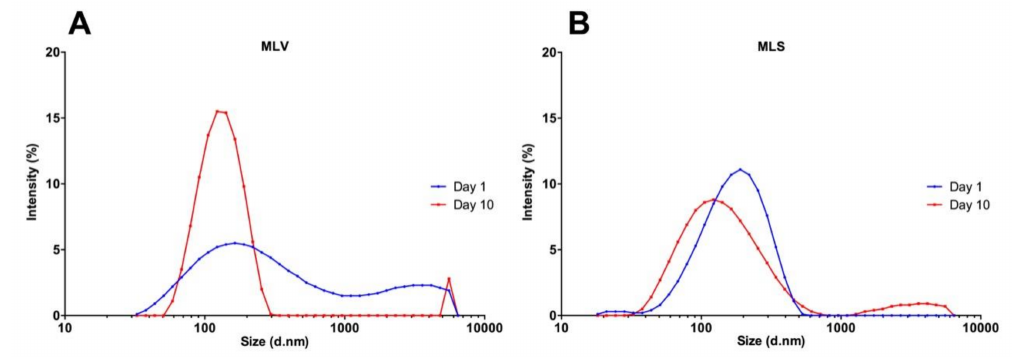
Figure 4. Analysis particle size distribution measured by dynamic light scattering (DLS). Distribution of the MLS ( A ) and MLV ( B ). The first day (blue line) and tenth day (red line).